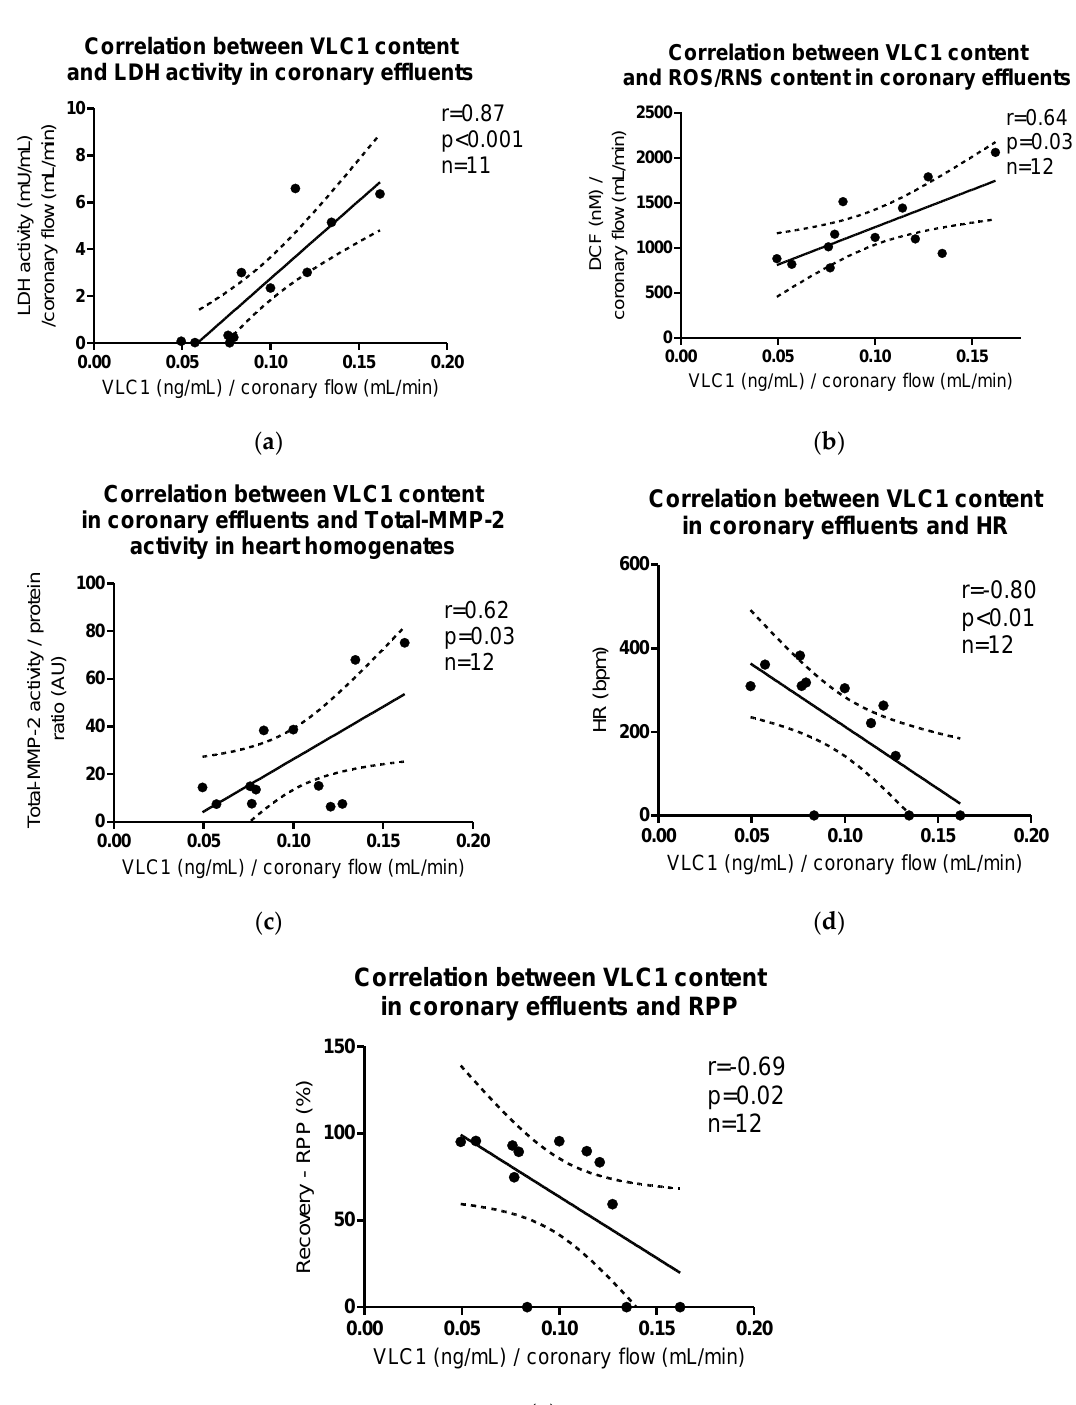
Figure 8. Correlations between VLC1 content in coronary effluents and ( a ) LDH activity, ( b ) ROS/RNS content, ( c ) Total-MMP-2 activity in myocytes, ( d ) heart rate (HR), ( e ) recovery of heart mechanical function (RPP).